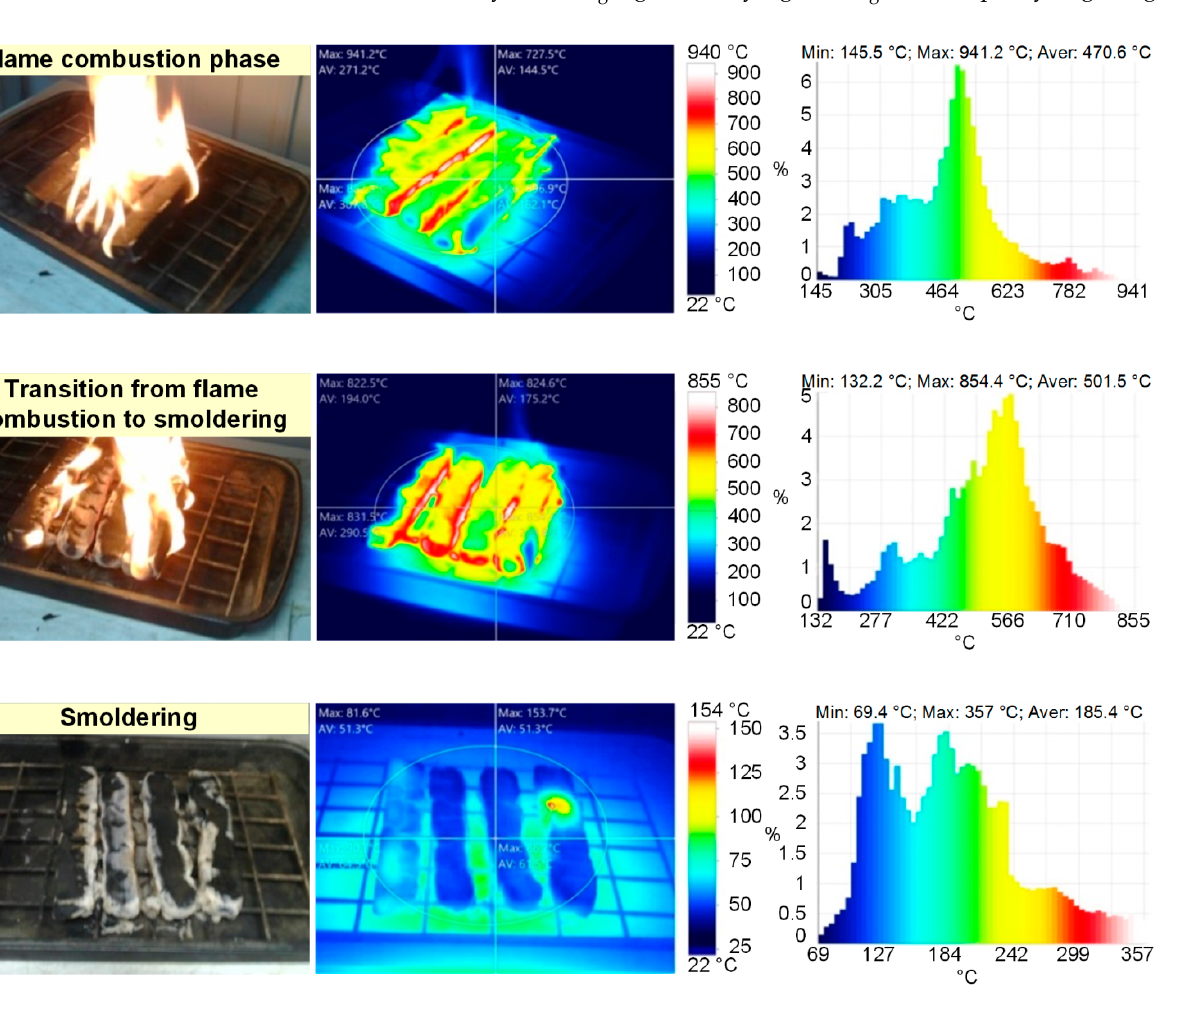
Figure 3. Thermal images of model fire (wood) combustion (flame combustion phase; transition from flame combustion to smoldering; smoldering).